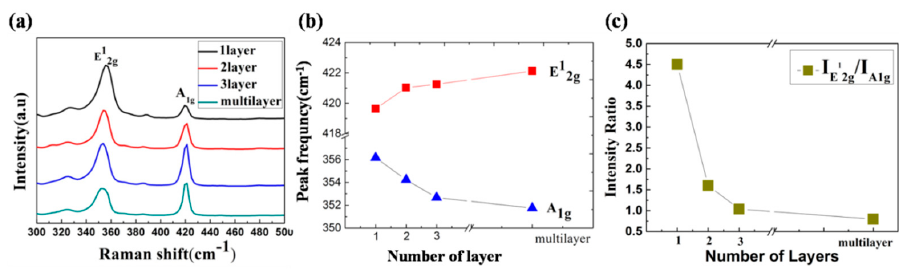
number of WS 2 layers, the ratios of I used as an effective way to identify the WS 2 films with different thicknesses.